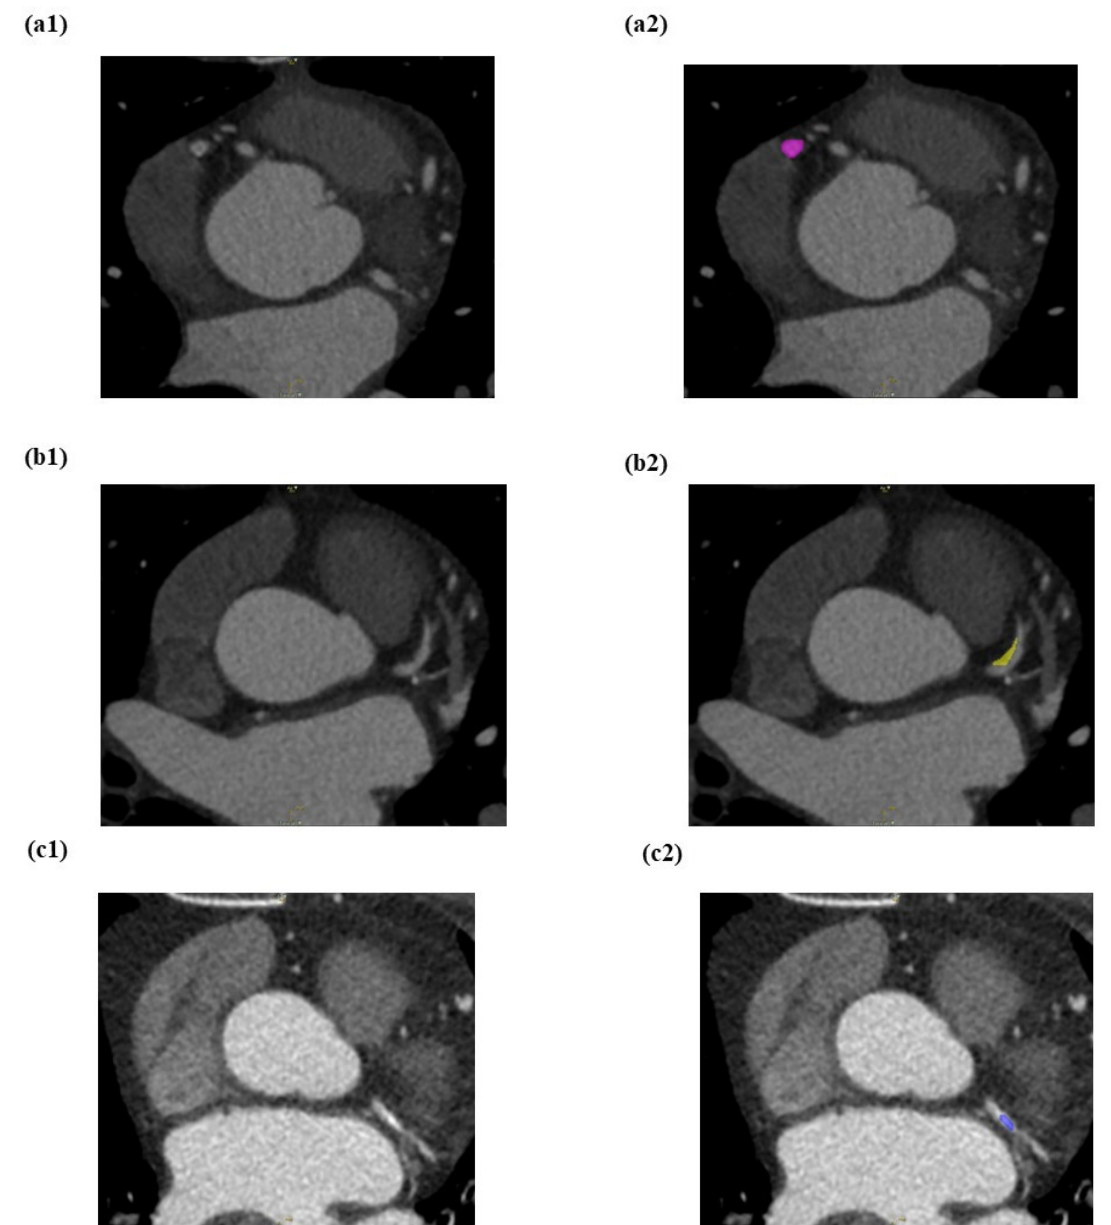
Figure 5. LIFEx software is used to perform semi-automated segmentation on RCA, LAD, and LCX. ( a1 ) Mid RCA with a mixed calcified atherosclerotic plaque seen. ( a2 ) The mixed calcified plaque was enclosed by the VOI placement (pink colour) on the mid RCA. ( b1 ) Proximal LAD with a non-calcified atherosclerotic plaque was seen. ( b2 ) The non-calcified plaque was surrounded by the VOI placement (yellow colour) on the proximal LAD. ( c1 ) Proximal LCX with a calcified atherosclerotic plaque was observed. ( c2 ) The calcified atherosclerotic plaque was surrounded by the VOI placement (blue colour) on the proximal LCX.